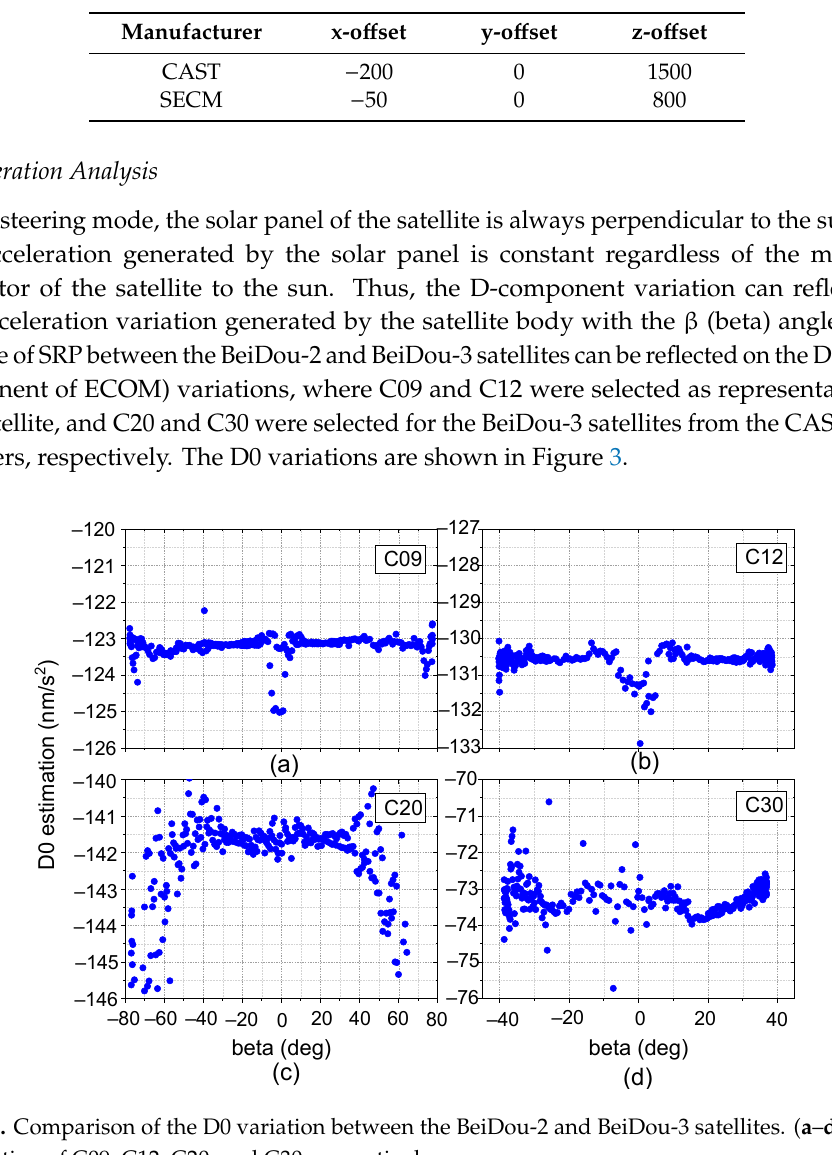
Table 2. The coarse parameters of BeiDou-3 satellite phase center offsets (PCOs). The unit is mm.